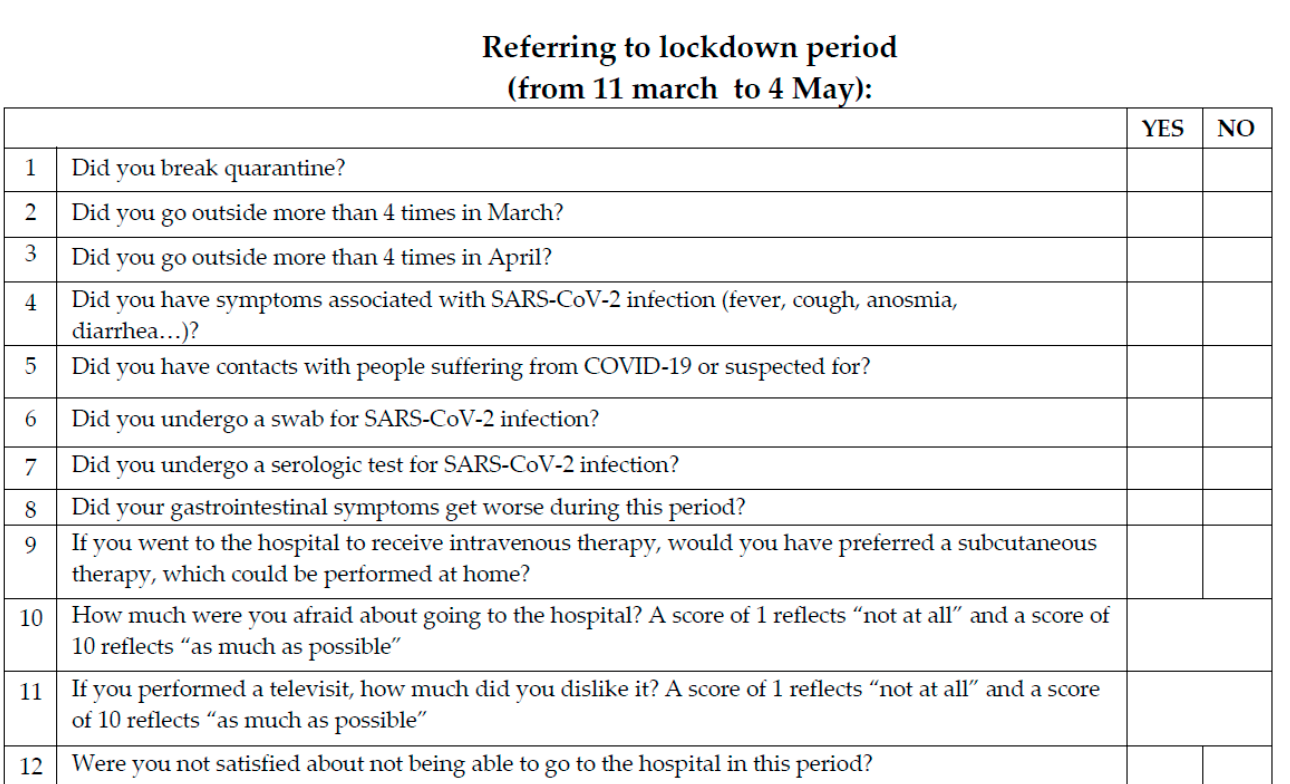
Figure 1. The 12 COVID-related additional questions administered to patients.